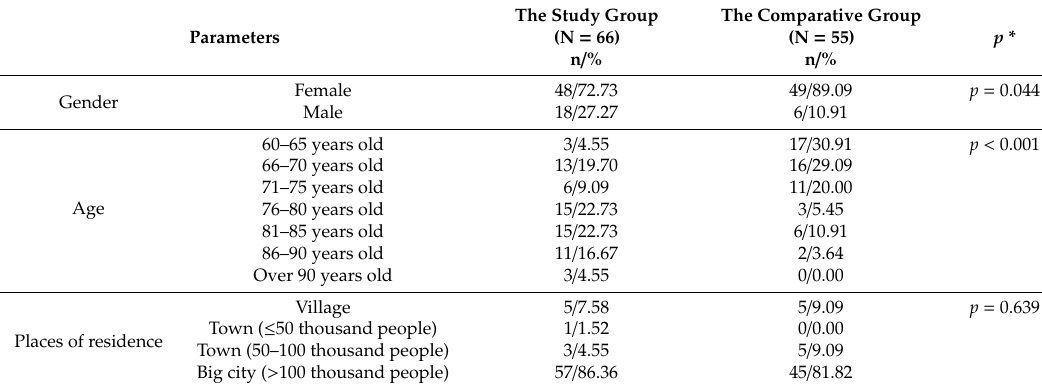
Table 1. The comparison of study participants in terms of sociodemographic